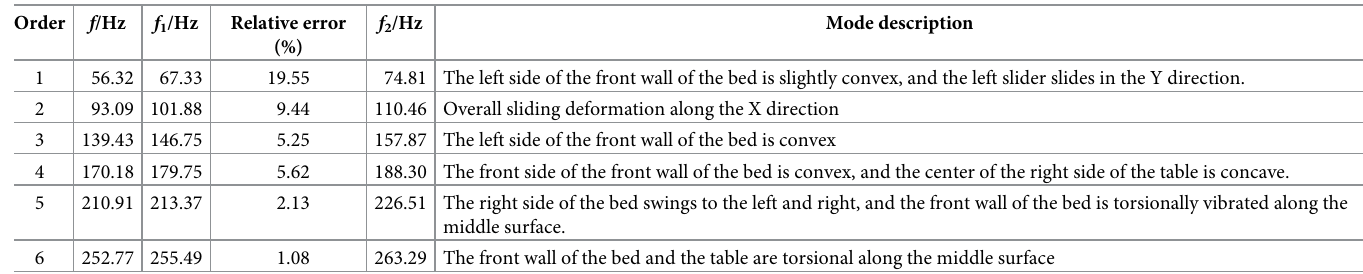
Table 3. Comparison of test frequency and simulation analysis frequency.